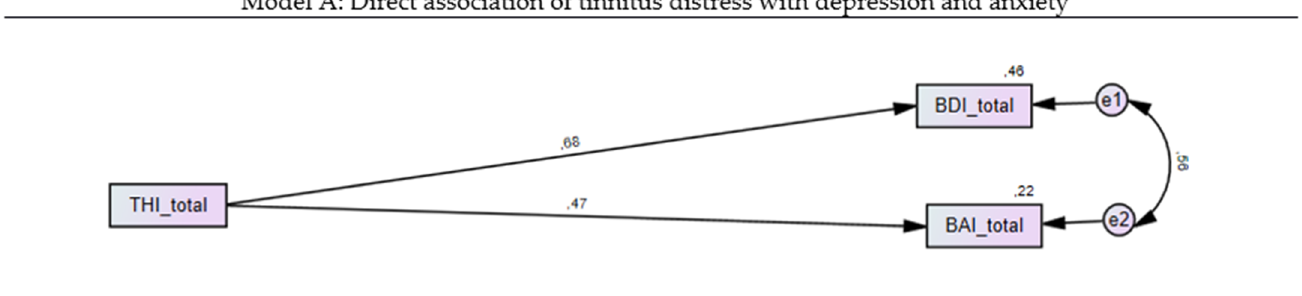
Figure 2. Structural equation model (SEM) for the direct influence of tinnitus distress on depression and anxiety. Rectangles represent variables and circles represent error terms (e). Arrows indicate paths, double arrows represent covariances. Numbers next to arrows in the model represent statistically significant standardized estimates, numbers next to factors represent the R 2 , i.e., the explained variance.